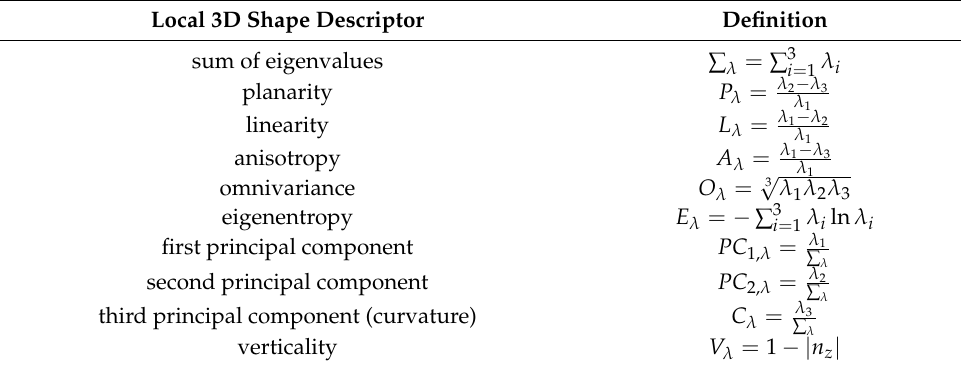
Table 1. 3D shape features extracted from the neighborhood geometry